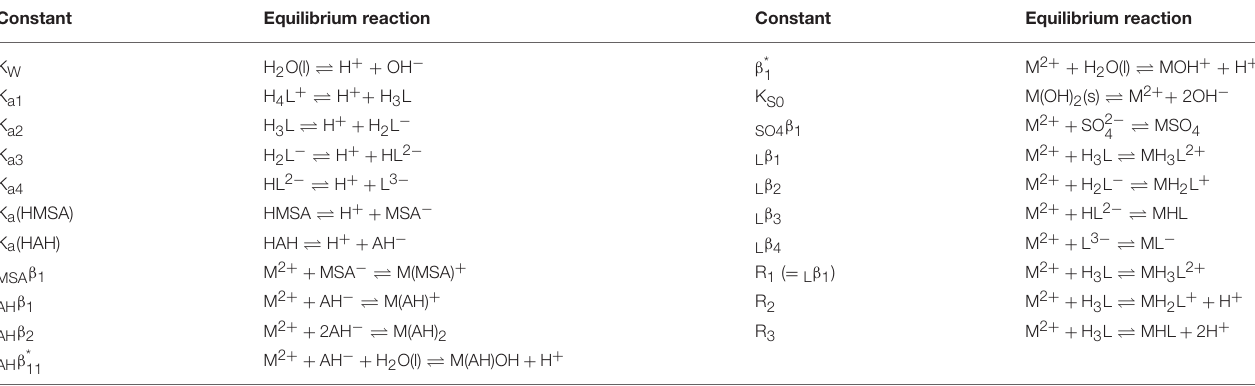
TABLE 1 | Definitions of equilibrium constants used throughout the text. Constant Equilibrium reaction Constant Equilibrium